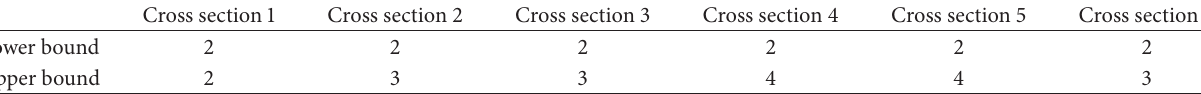
Table 1: Lower and upper bounds of the exponents over the cross sections in Figure 2.